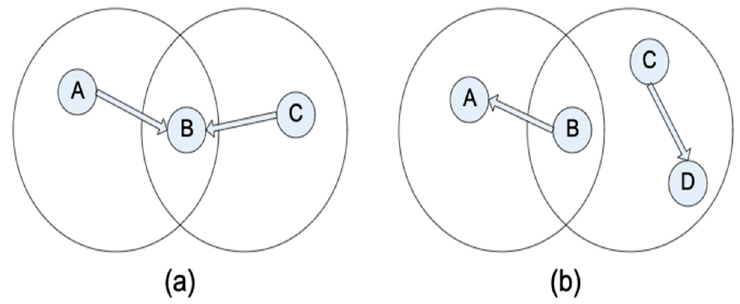
Figure 2. (a) The Hidden and (b) Exposed Terminal Problem. Figure 2. ( a ) The Hidden and ( b ) Exposed Terminal